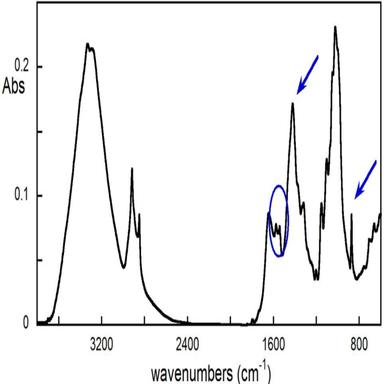
FTIR spectrum of the page 230 of the volume 410. The arrows indicate the band attributable to starch, while circle to molecules from cellulose degradation containing carbonyl and carboxyl groups.